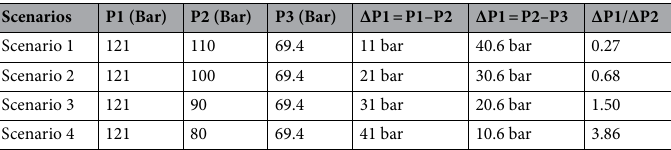
Table 1. Scenarios examined for intermediate pressure ratio.